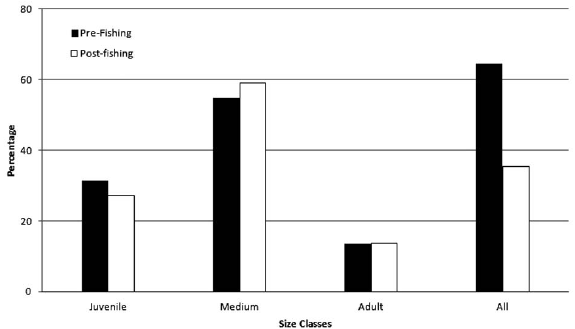
Table 1. – Summary of the semivariogram models, Gaussian (Gaus) and spherical (Sph); relative descriptors (lag, nugget, sill and range) and goodness of fit criteria based on sea urchin density by size. Lag (in metres); C percentage), spatially structured component; r 2 , coefficient of determination; RSS, reduced sum of